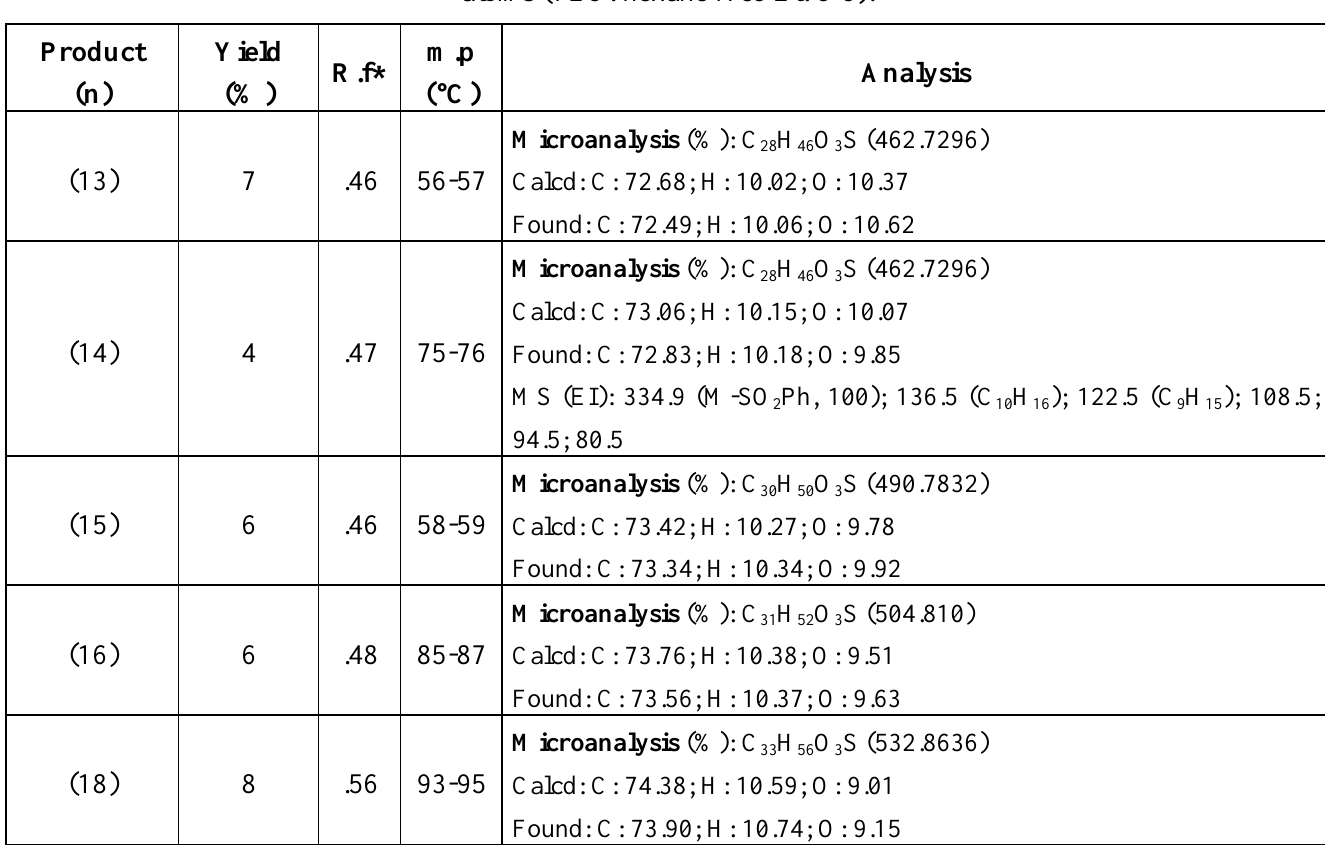
Table 3. Analysis of compounds 17 bearing an aliphatic side chain that ranged from 13 to 18 carbon atoms (TLC: hexane-AcOEt: